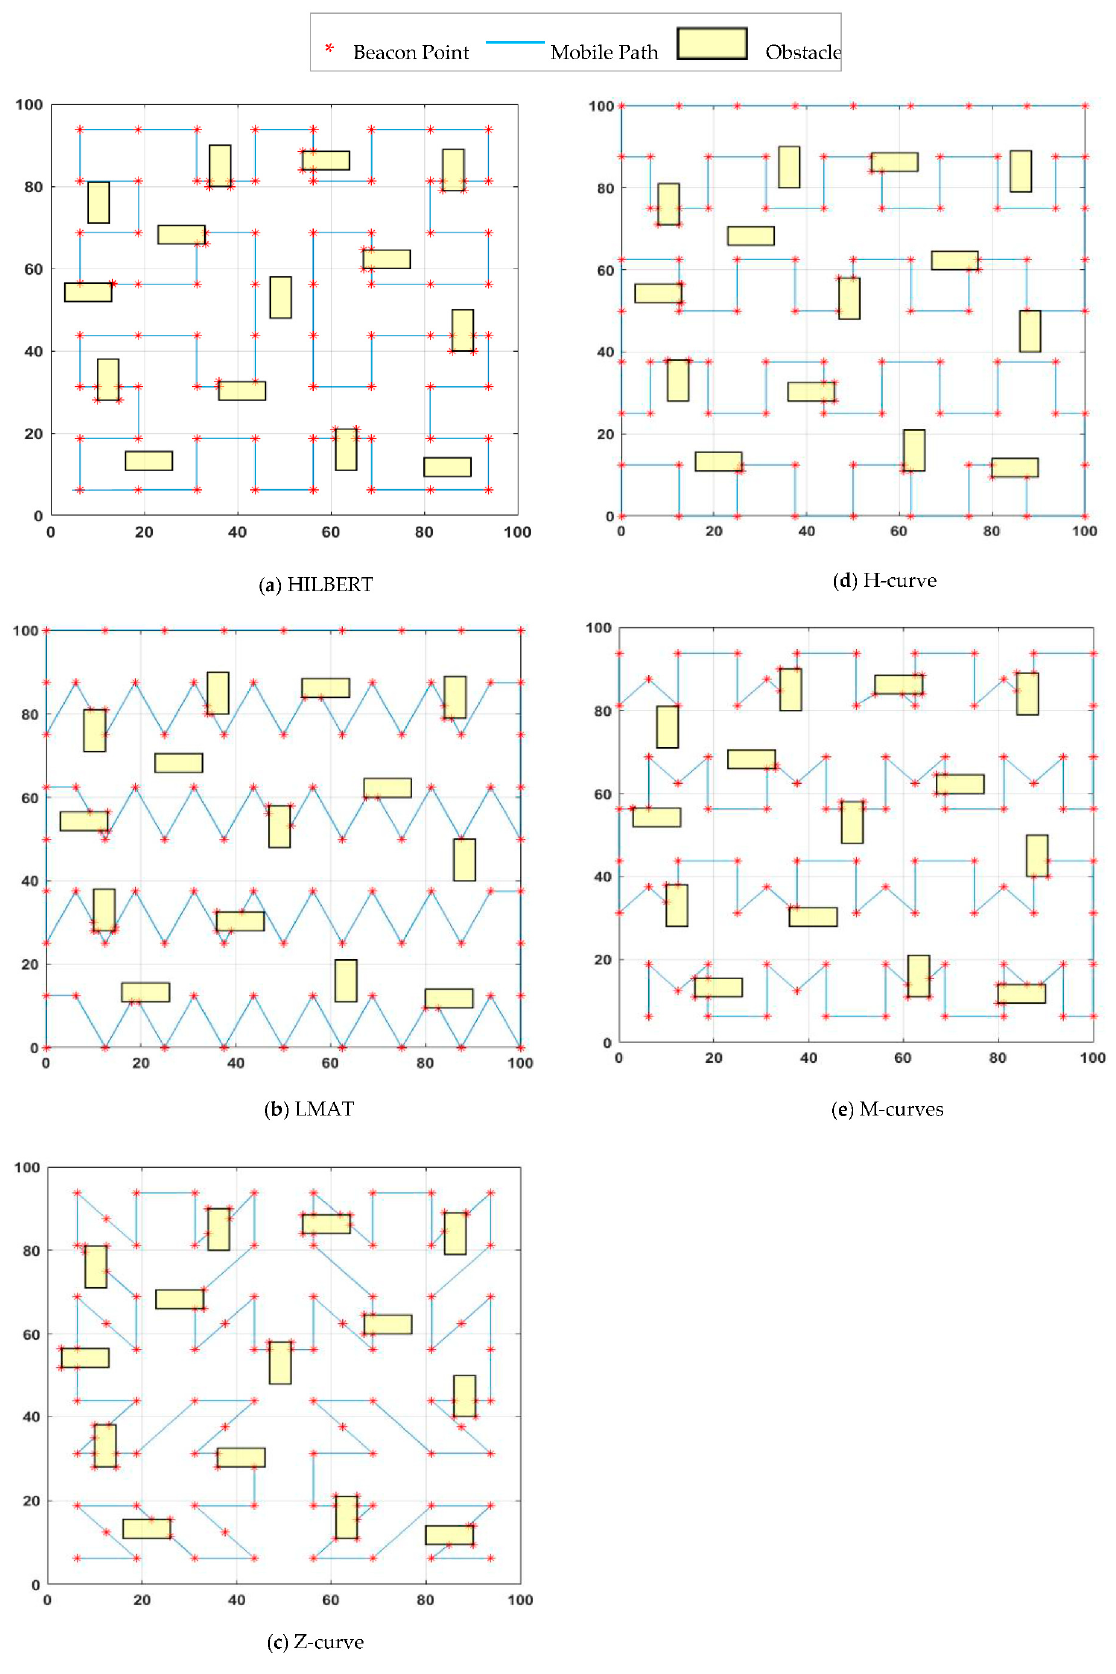
Figure 5. The obstacle-handling trajectories of the path planning models.